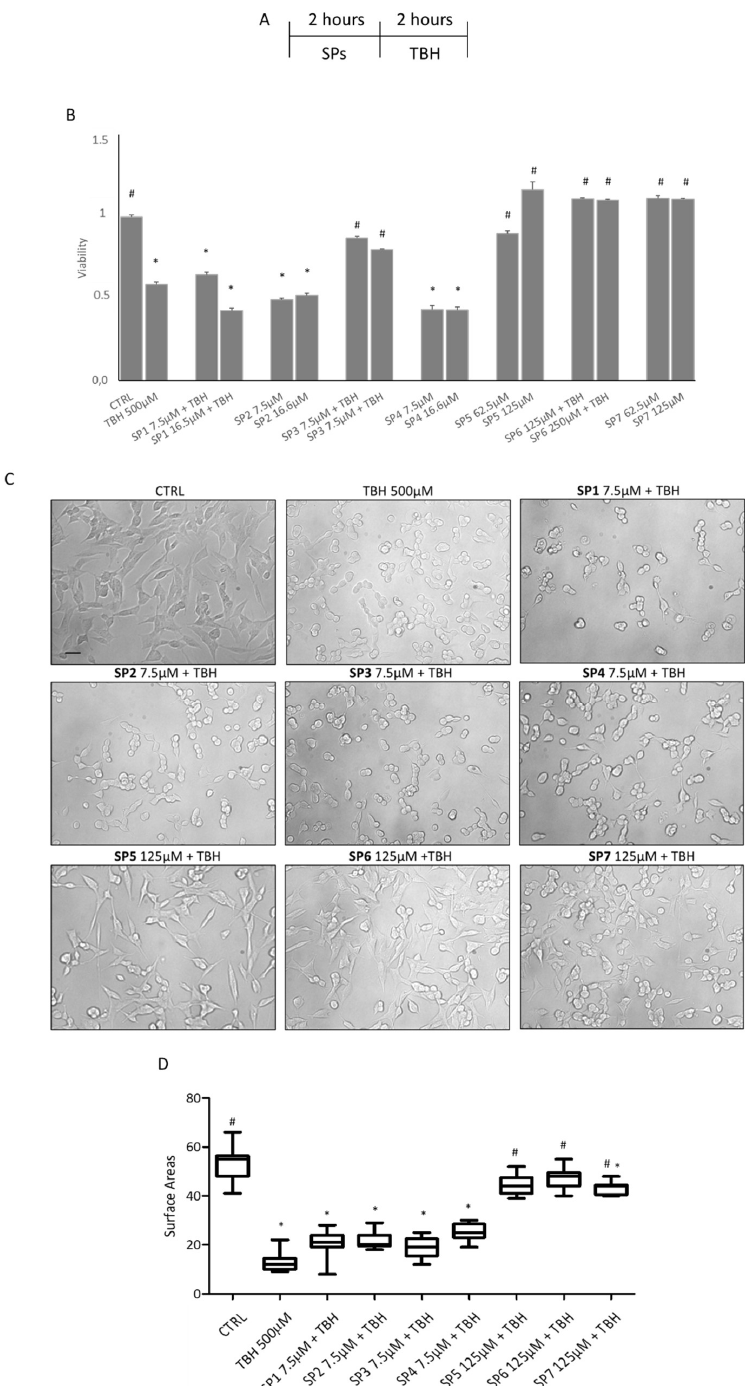
Figure 3. Antioxidant and protective effects of MITO compound treatment against TBH-induced oxidative stress, pretreatment. ( A ) Schematic representation of the pretreatment with the MITO compounds. ( B ) MTS assay of cytoprotective effect of the MITO compounds (2 h) on cells pretreated with TBH (2 h, 500 µM). ( C ) Representative morphological images. ( D ) Graphic of cellular body areas. Bar: 50 µm. Tukey test: * p < 0.05 compared to CTRL group; # p < 0.01 compared to TBH group.